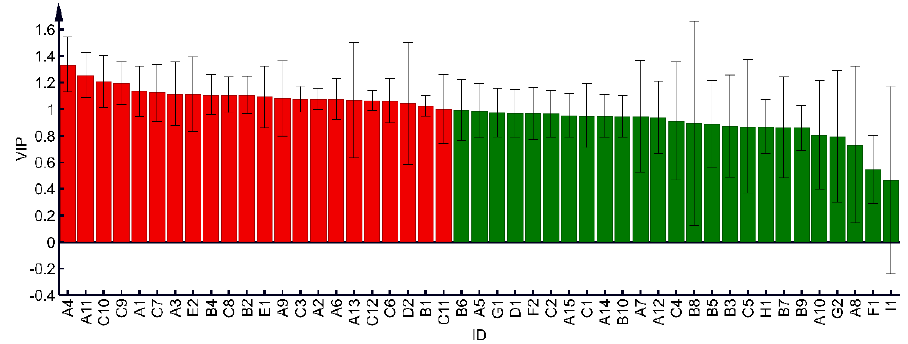
Figure 7. VIP map of VOCs during storage of alfalfa.